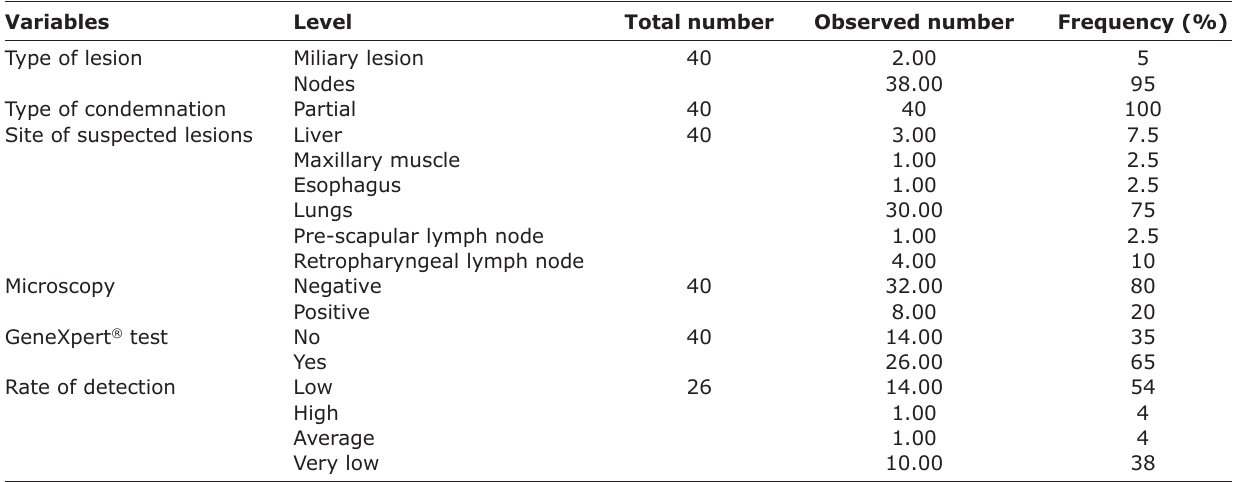
Table-1: Macroscopic, microscopic, and molecular